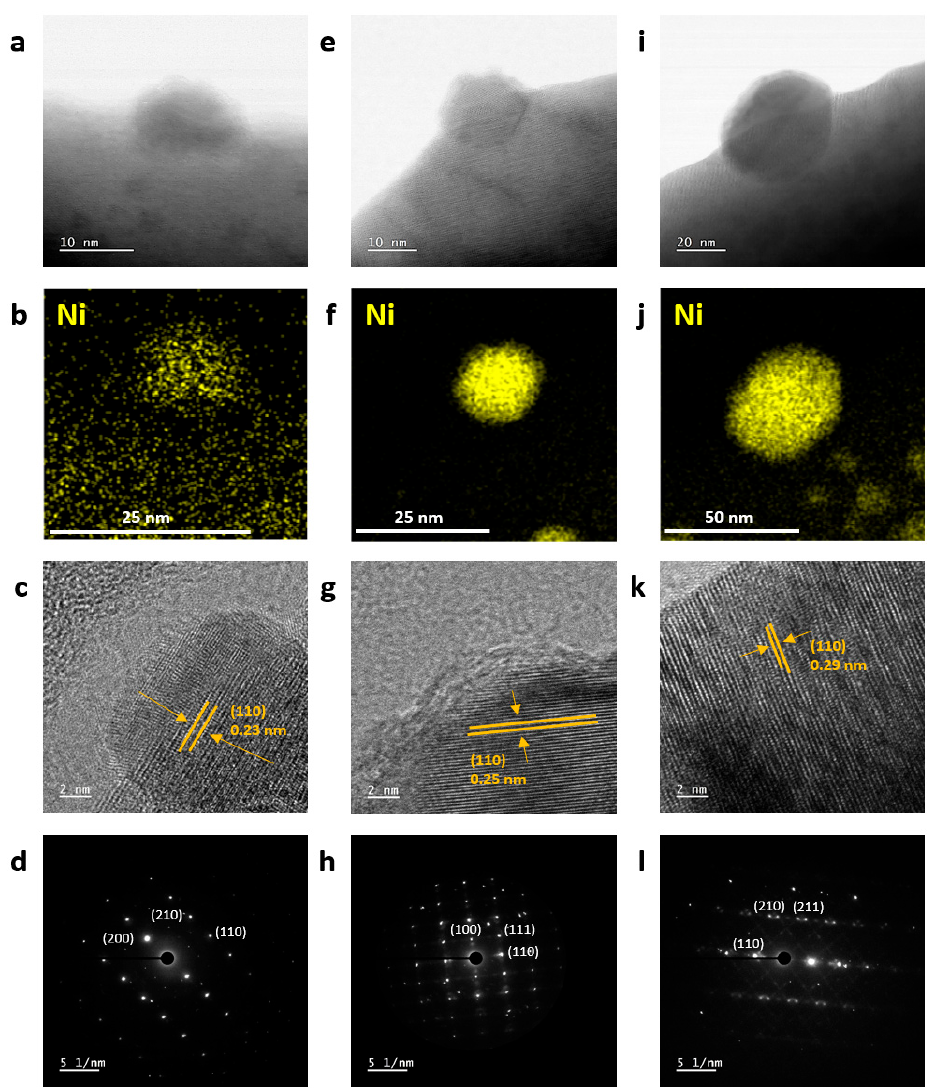
Figure 3. Morphological characterization of Ni-exsolved perovskite oxides, showing HR-TEM images, EDS mapping, and SAED patterns of ( a – d ) LCNT-R6, ( e – h ) LCNT-R7, and ( i – l ) LCNT-R8.